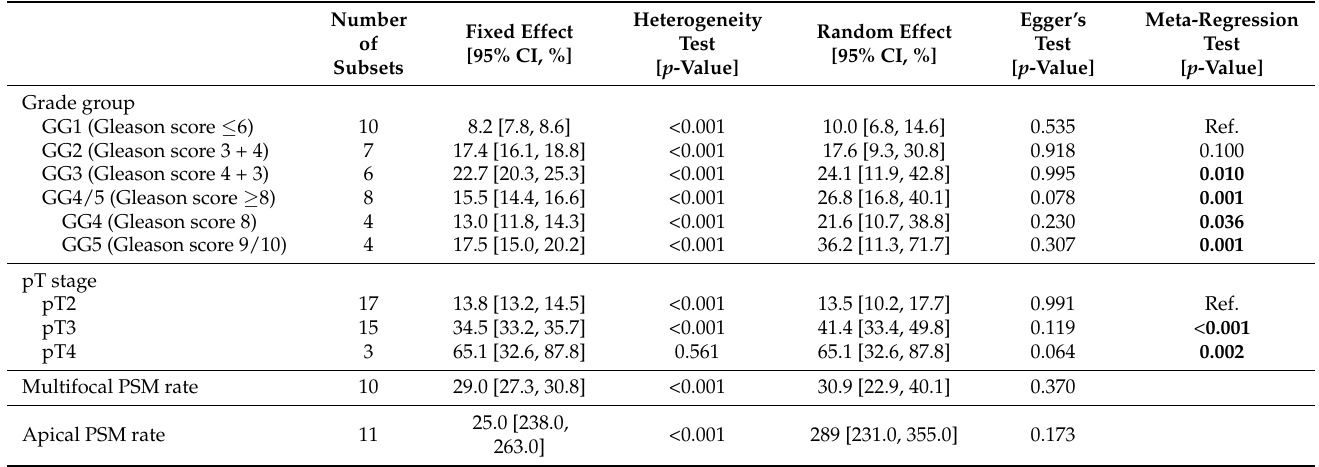
Table 3. Detailed analysis of the estimated rates of positive surgical margin after radical prostatectomy in prostatic cancers.